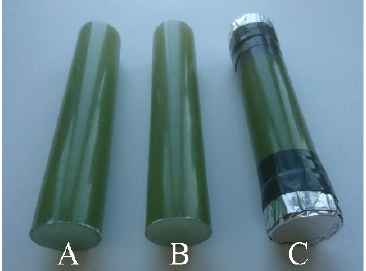
Figure 2. Glass-reinforced epoxy (GRE) material samples of the high voltage alternating current (HVAC) composite insulator carrying rod. From the left: reference sample—group A; thermally aged sample—group B; and DC and thermally aged sample—group C, with visible electrodes attached to the sample’s front surfaces.